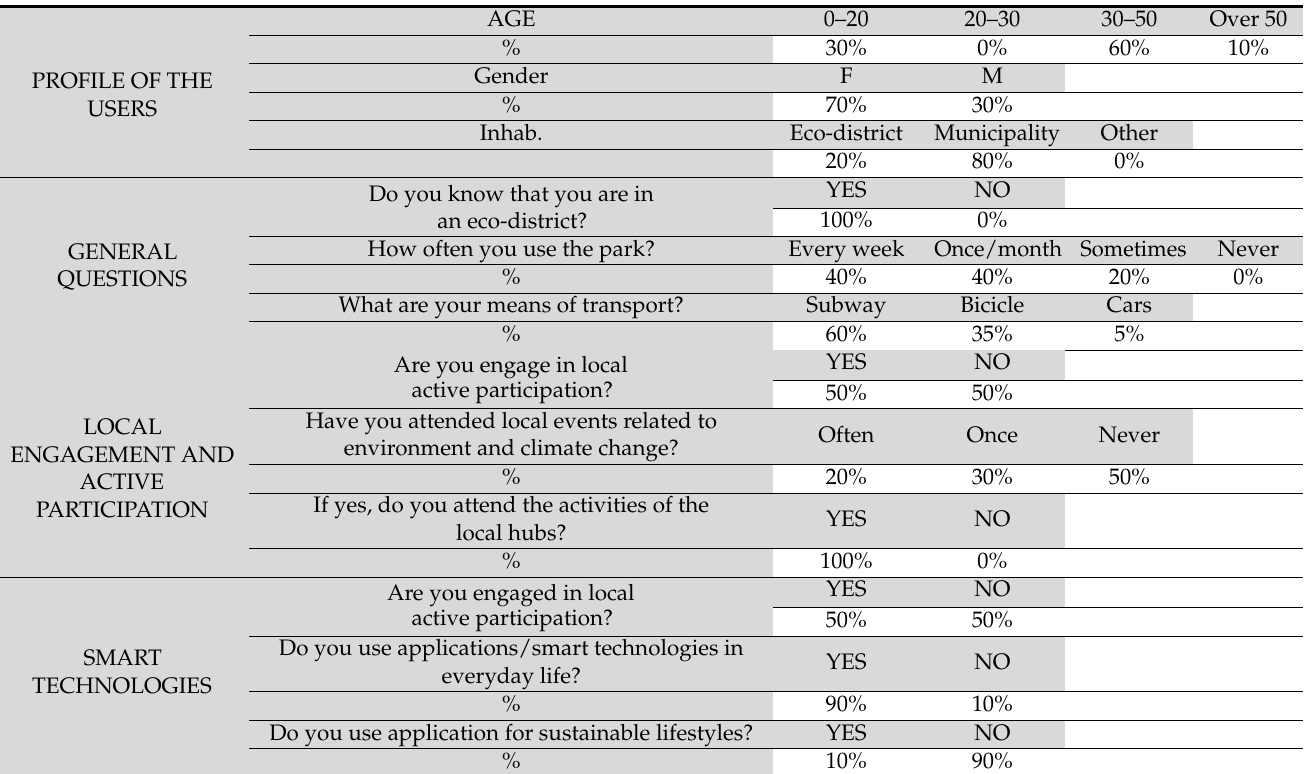
Table 16. The eco-district framework. Source: Authors’ elaboration (2022) from the results of the questionnaires